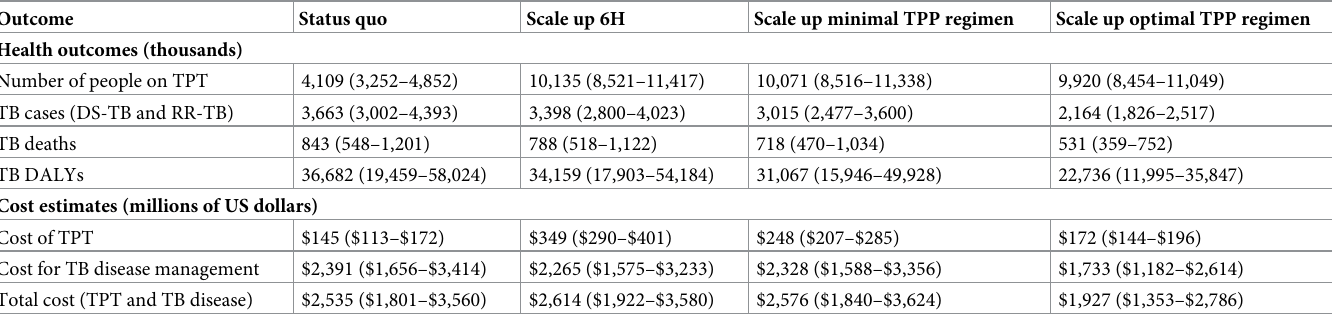
Table 3. Projected health impacts and costs (95%uncertainty ranges) for TPT and TB treatment: South Africa 2020–2035. Outcome Status